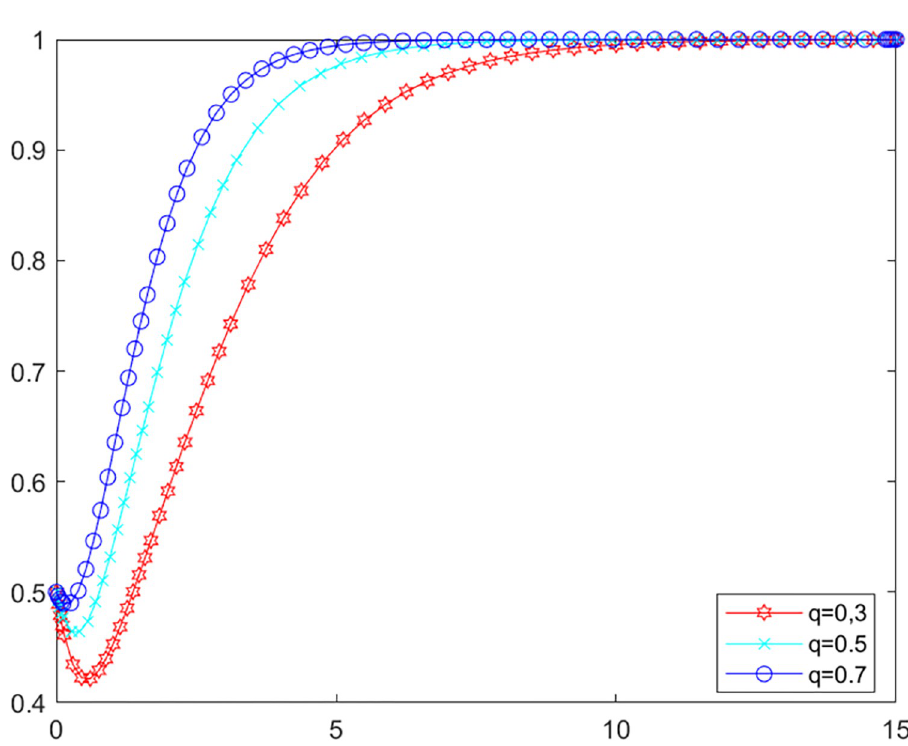
Fig 9. LPBE’s evolutionary